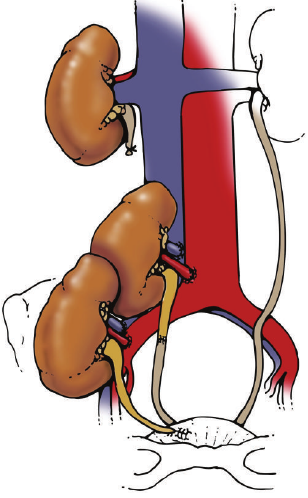
Figure 2: Ureteroureterostomy.